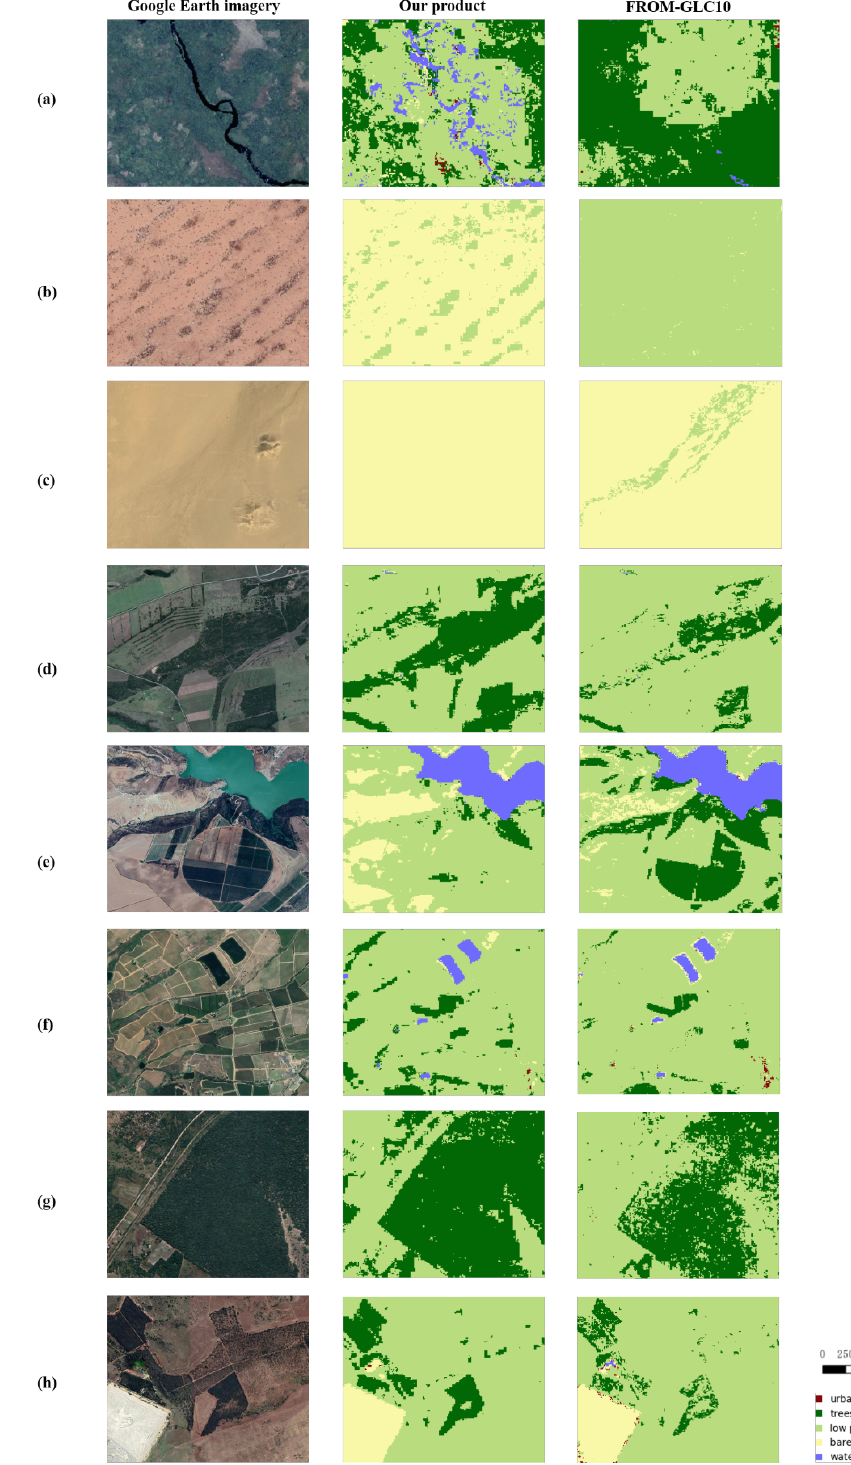
Figure 11. Google Earth imagery, our product, and the From-CLC10 product of the rural area in the climate zone from ( a ) Tropical wet climate (Aw), ( b ) Hot semi-arid climate (BSh), ( c ) Hot desert climate (BWh), ( d ) Temperate oceanic climate (Cfb), ( e ) Hot-summer Mediterranean climate (Csa), ( f ) Warm-summer Mediterranean climate (Csb), ( g ) Monsoon-influenced humid subtropical climate (Cwa), and ( h ) Subtropical highland climate